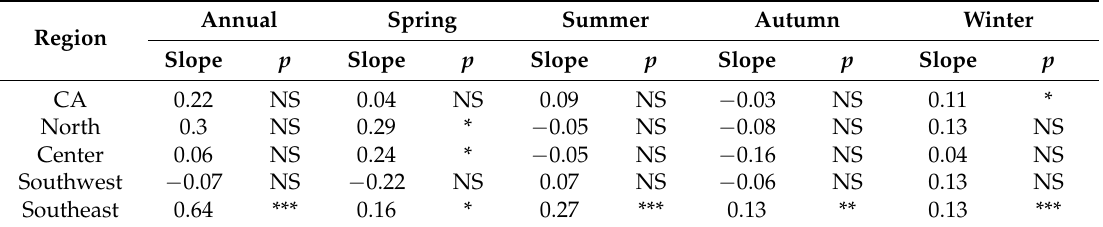
Symbols *, **, and *** represent significance at the 0.05, 0.01, 0.001 levels, respectively. NS indicates “not significant”.